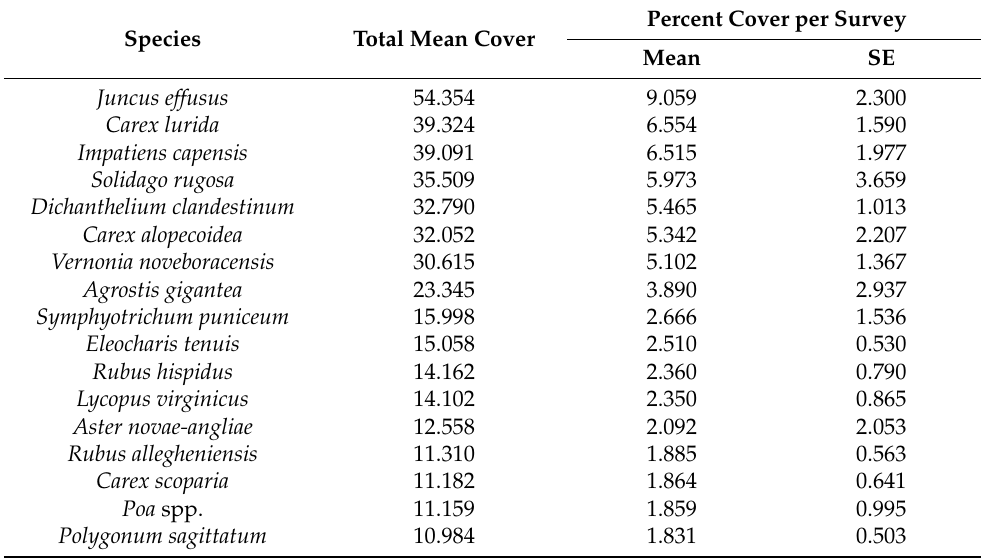
Table 6. Dominant plant species surveyed within the riparian area of Ruby Run at JW Ruby Research Farm in Preston County, West Virginia, USA, during September 2016, June and September 2017 and 2018, and July 2020. Dominant species were identified as contributing > 10% cover combined across all four years. Total mean plant cover was the combined mean percent cover for each species within quadrats across years, while mean plant cover was the estimated percent cover within quadrats per survey. All values are reported as percentages.